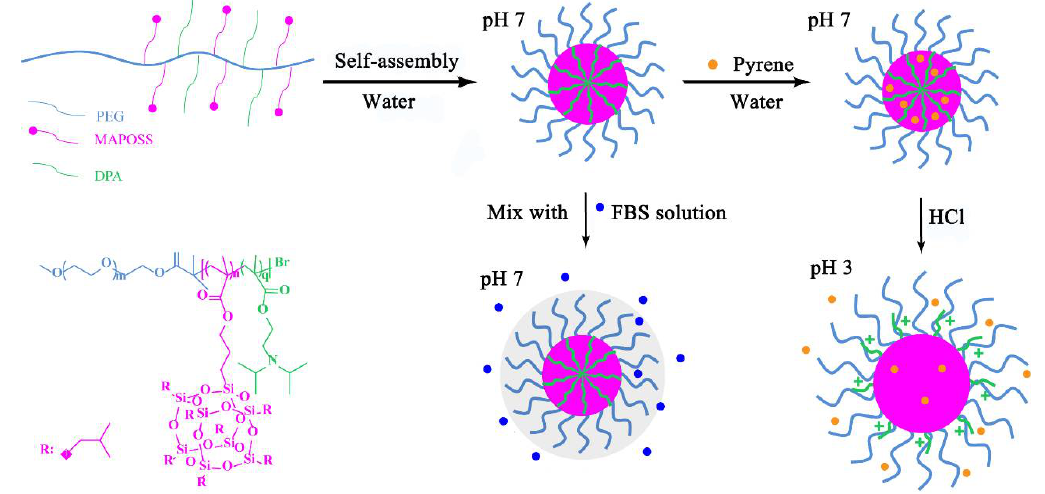
Figure 8. The fluorescent emission spectra of BCP1, BCP2 and BCP3 micelles encapsulated with pyrene in aqueous solution when pH = 7 ( a – c ) and pH = 3 ( d – f ) under an excitation wavelength of 336 nm along time.